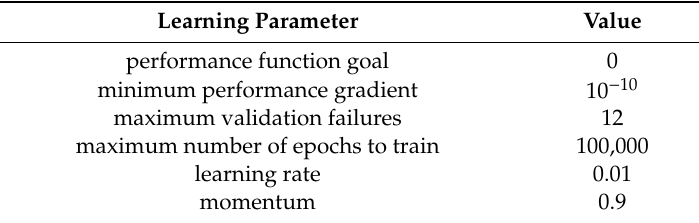
Table 1. Learning parameters for each